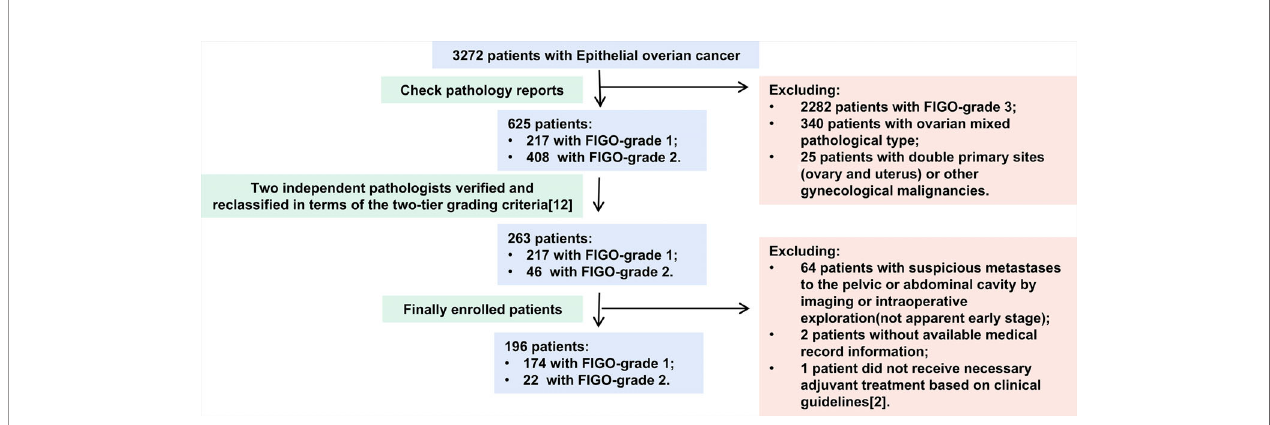
FIGURE 1 | The fl owchart of patients ’ inclusion and